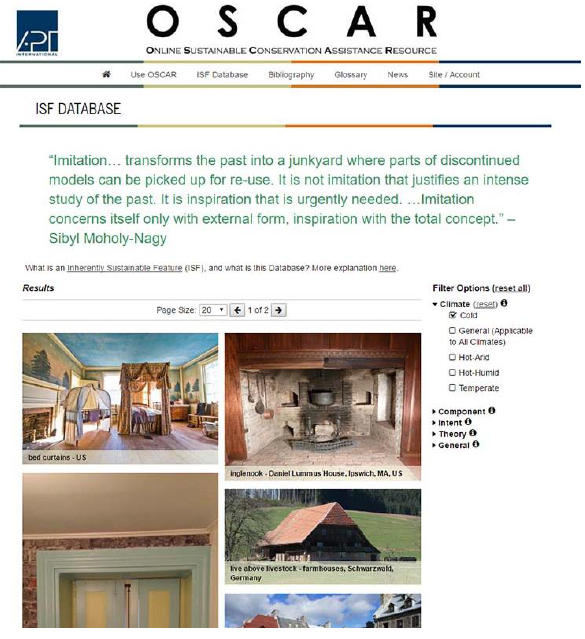
Figure 4. ISF database in OSCAR